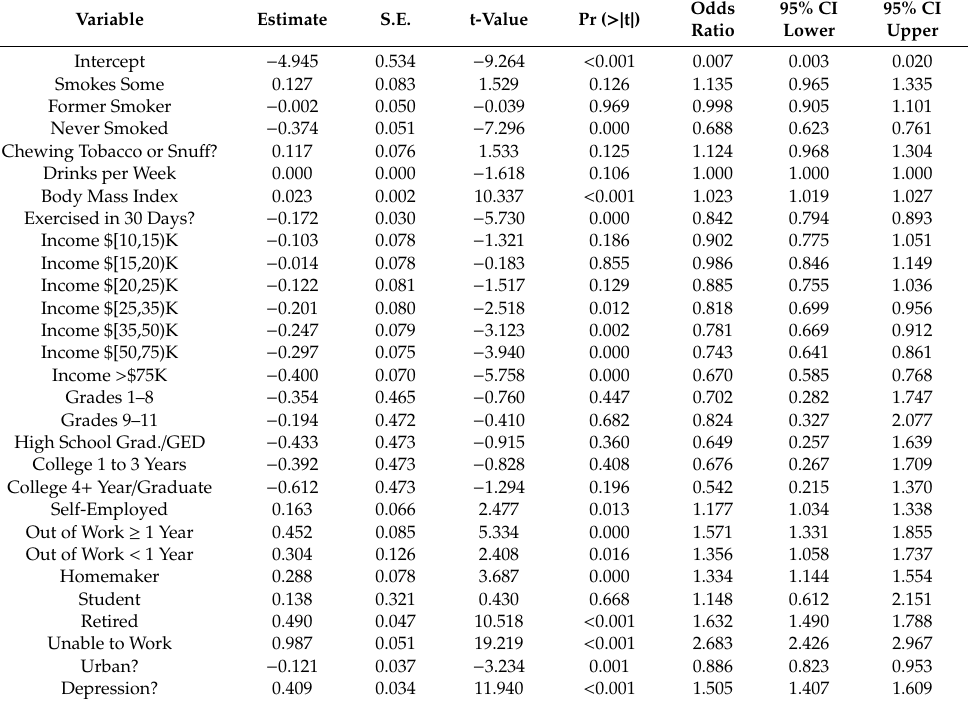
Table 7. Complete model with associated odds ratios and confidence